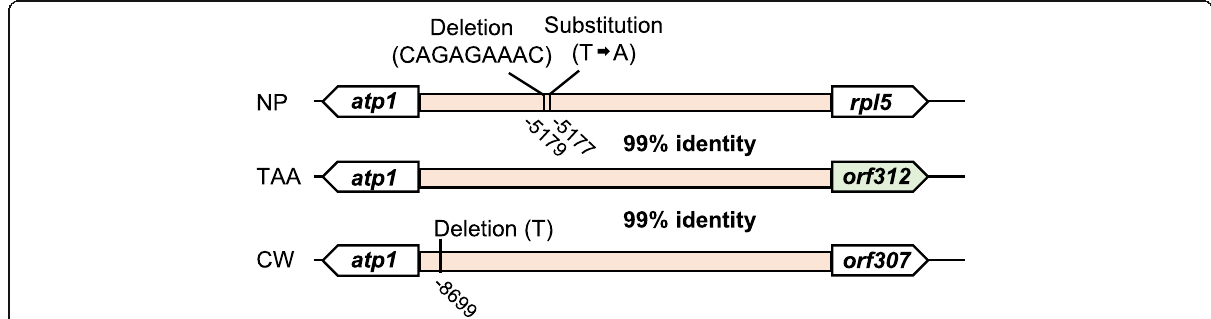
Fig. 5 Schematic structures of the upstream region of orf312 and homologous regions in Nipponbare (NP) and CW-type CMS (CW). Nucleotide identities are shown for the pink region. Substituted and deleted nucleotides are indicated with nucleotide positions from the start codon of rpl5 or orf307